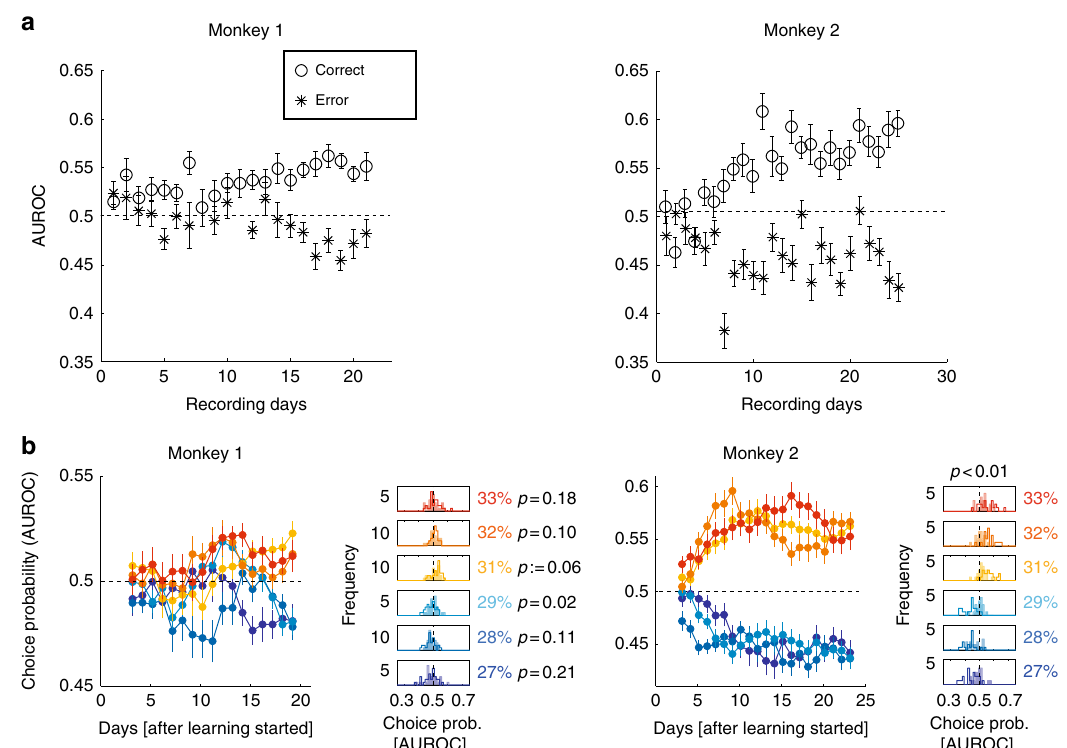
Fig. 4 Relation of neuronal activity to choices. a Average test – test AUROC values for the three hardest contrast pairs as a function of learning, analysed for correct and error trials. Error bars show S.E.M.s for averages across the 3 contrast pairs and 3 consecutive learning days (note that some error bars are smaller than the symbols and thus close to invisible). b Choice probability as a function of learning for both monkeys for different test contrasts (colour coded and displayed as insets). Left column: Choice probability for test activity levels (separately for the three hardest contrast levels below and above sample contrast, respectively). Insets in b show distributions of choice probabilities for the fi rst 5 days of learning ( fi lled histograms) and the last 5 days of learning (outlined histograms). p Values for distribution differences are indicated above the top histogram for each main comparison and next to the individual histogram plots if different thereof . Data in b are averaged over 5 consecutive days, i.e. number of data points = recording days minus 4. Error bars denote S.E.M. ( n = 29 and n = 20 per data point for monkeys 1 and 2,